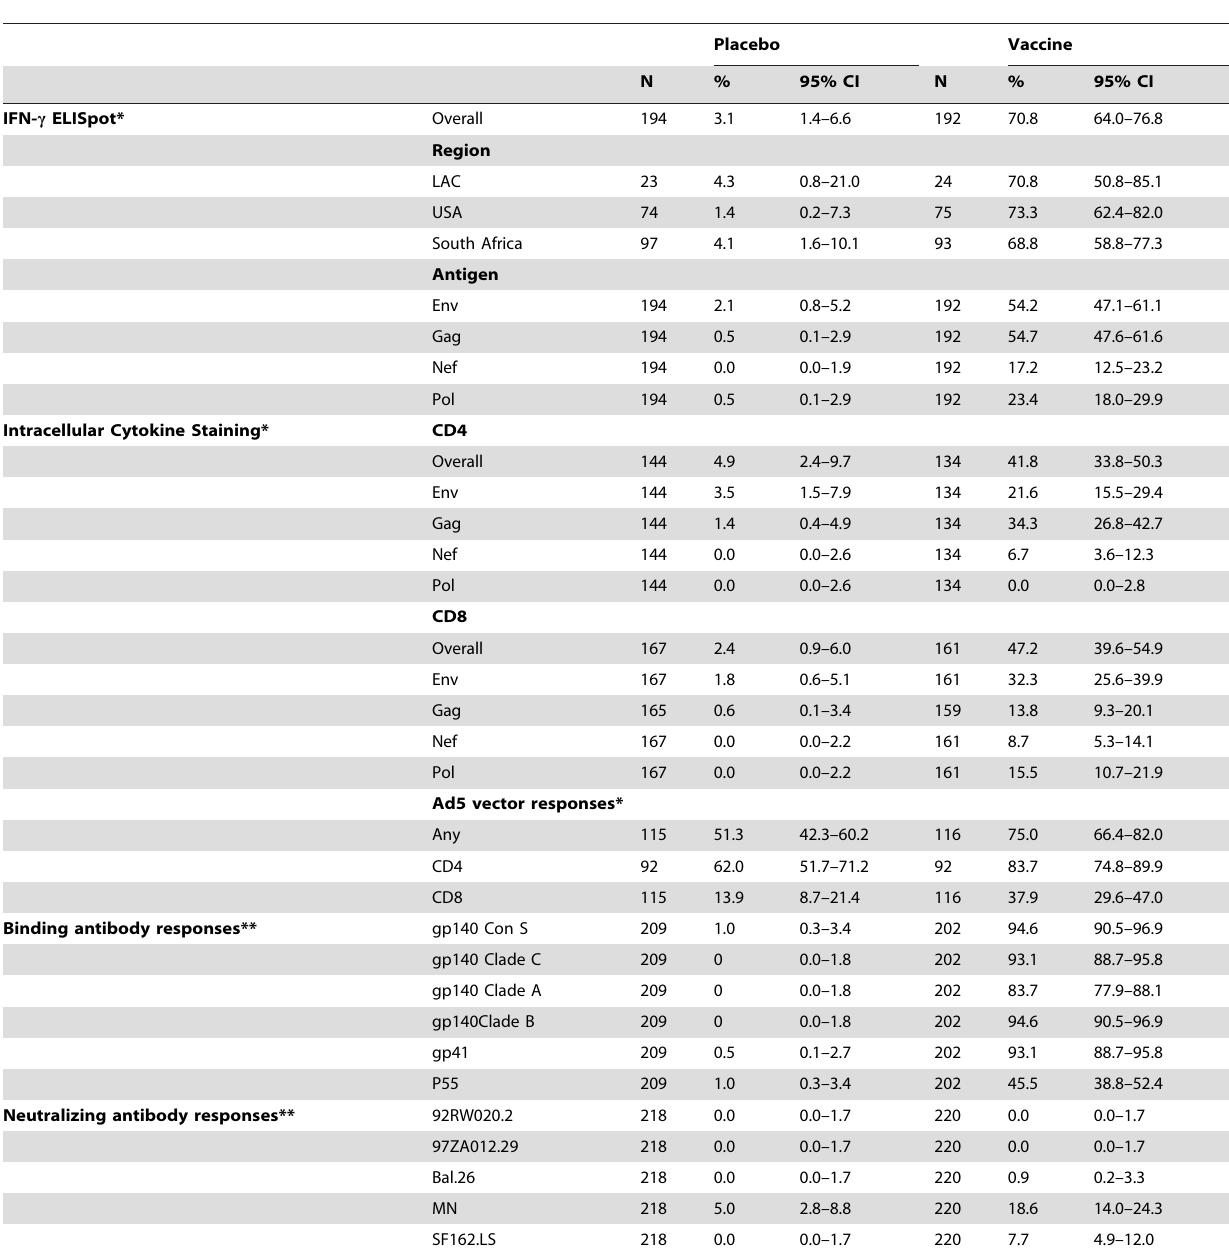
Table 3. Frequency of interferon- c T cell ELISpot, intracellular cytokine staining, binding and neutralizing antibody and Ad5 vector